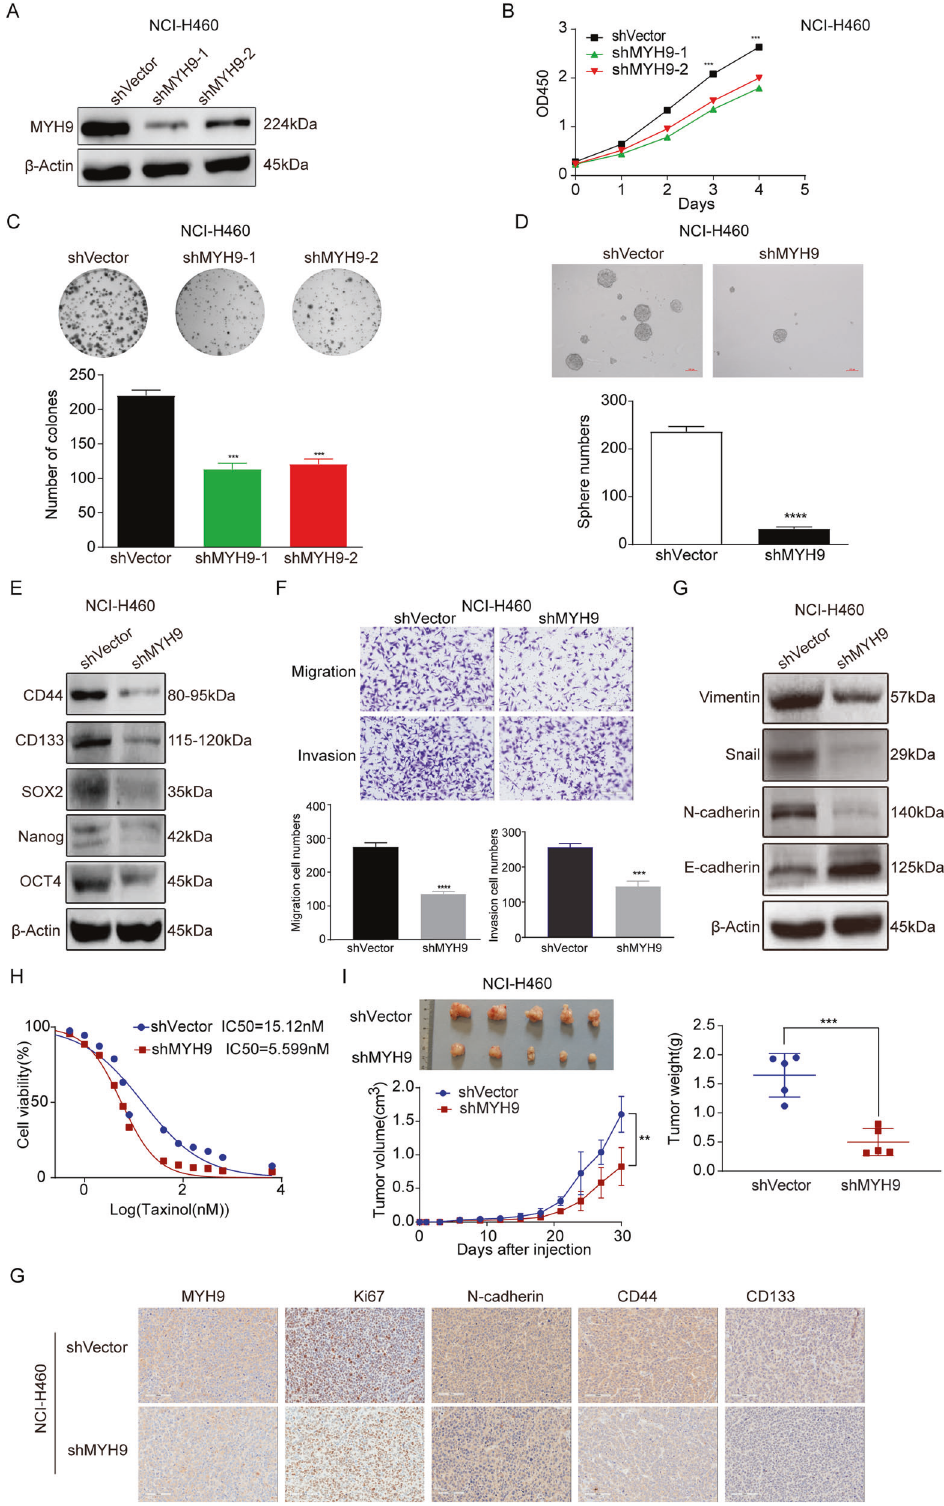
Fig. 2 Downregulation of MYH9 expression suppresses the stem cell-like malignant phenotype of LCCs in vivo and in vitro. A The protein expression of MYH9 in NCI-H460-shMYH9 stable transformant and control cells. B , C Proliferation ability of NCI-H460-shMYH9 and NCI-H460- shVector cells (mean ± SD; n = 3; *** p <0.001; Student ’ s t -test). D Test results of self-renewal ability of NCI-H460-shMYH9 and NCI-H460-shVector cells (mean ±SD; n = 3; **** p <0.0001; Student ’ s t -test). E The expression of CD44, SOX2, CD133, OCT4, and Nanog in NCI-H460-shMYH9 and NCI-H460- shVector cells. F Analysis of migration and invasion ability of MYH9 stable knockdown and control cells (scale bar, 200 μ m; mean ± SD; n = 3; *** p < 0.001 and **** p < 0.0001; Student ’ s t -test). G Western blot of EMT marker in NCI – H460 – shMYH9 and NCI-H460-shVector cells. H Analysis of drug resistance of NCI-H460-shMYH9 and NCI-H460-shVector cells to paclitaxel. I Analysis of the effect of MYH9 knockout on the growth of LCCs in vivo by subcutaneous tumor formation assay (mean ±SD; n = 5; ** p < 0.01 and *** p < 0.001; Student ’ s t -test). J IHC analysis of N-cadherin, MYH9, CD133, CD44, and Ki67 in xenografts of NCI-H460-shMYH9 and NCI-H460-shVector cells (scale bar, 100 μ m; n = 5). Cell Death Discovery (2021)